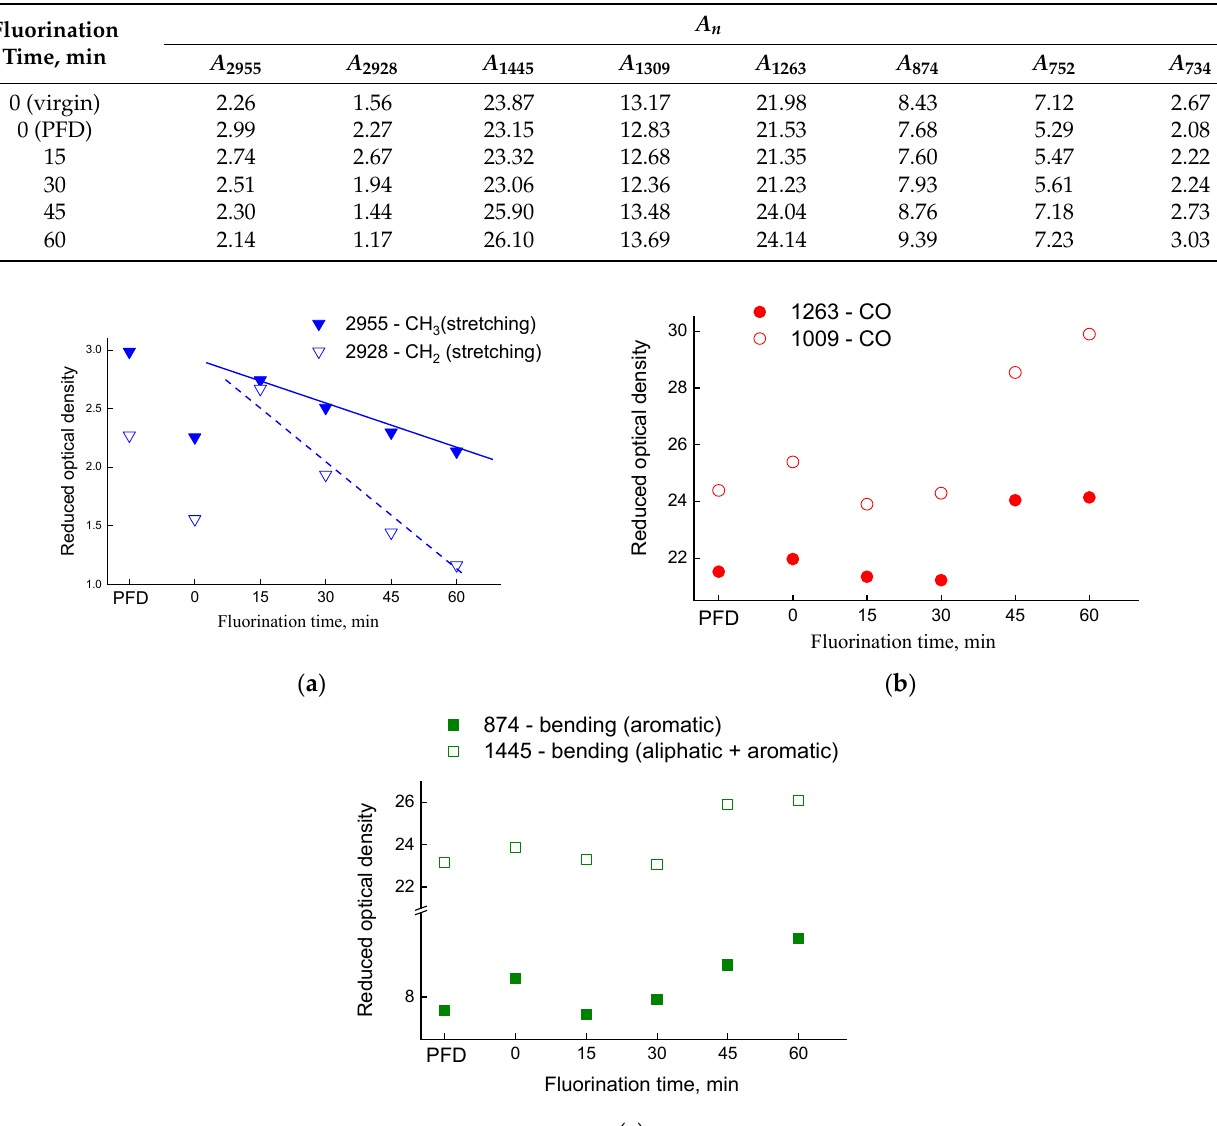
Table 1. Reduced optical density ( A n ) for PIM-1 films depending on the fluorination time; n is the wavenumber at the maximum of the absorption band.